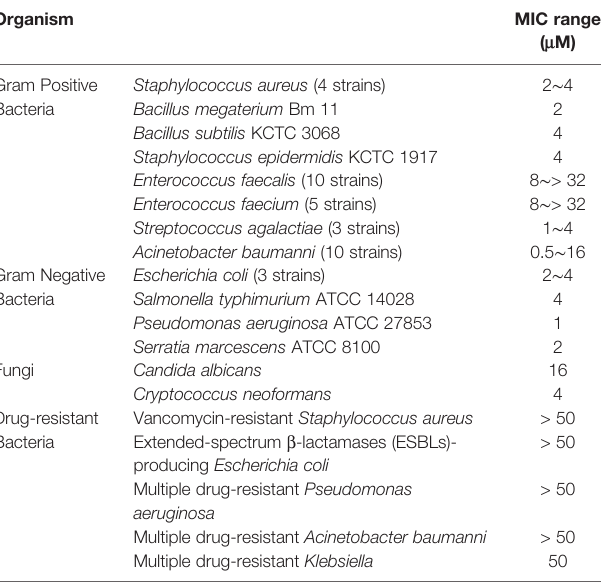
TABLE 1 | MICs of Bomidin against various bacteria and fungi.